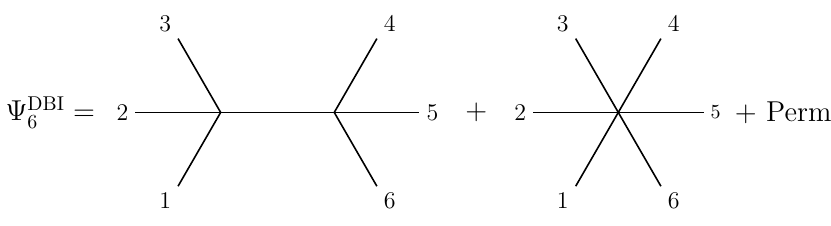
Figure 1 . Witten diagrams contributing the 6-point sGal wavefunction coefficient.